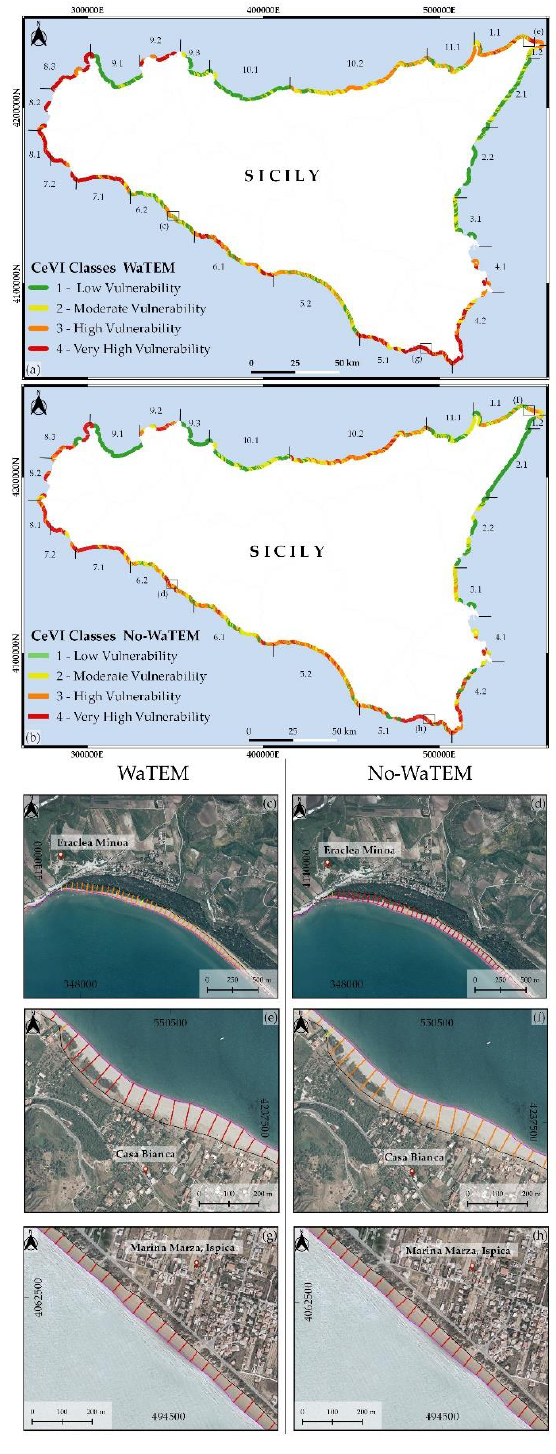
Figure 8. The Sicilian coastal erosion vulnerability maps obtained by using, respectively, the WaTEM (subplot a ) and the No-WaTEM (subplot b ) models. (Subplots c , d ) show the Eraclea Minoa beach (Trapani) vulnerability classes computed, respectively, with the WaTEM and No-WaTEM models. (Subplots e , f ) show the Casa Bianca beach (Messina) vulnerability classes computed, respectively, with the WaTEM and No-WaTEM models. (Subplots g , h ) show the Ispica beach (Ragusa) vulnerability classes computed, respectively, with the WaTEM and No-WaTEM models. The four vulnerability classes, from 1 (low vulnerability) to 4 (very high vulnerability), are depicted, respectively, by four colors: green, yellow, orange and